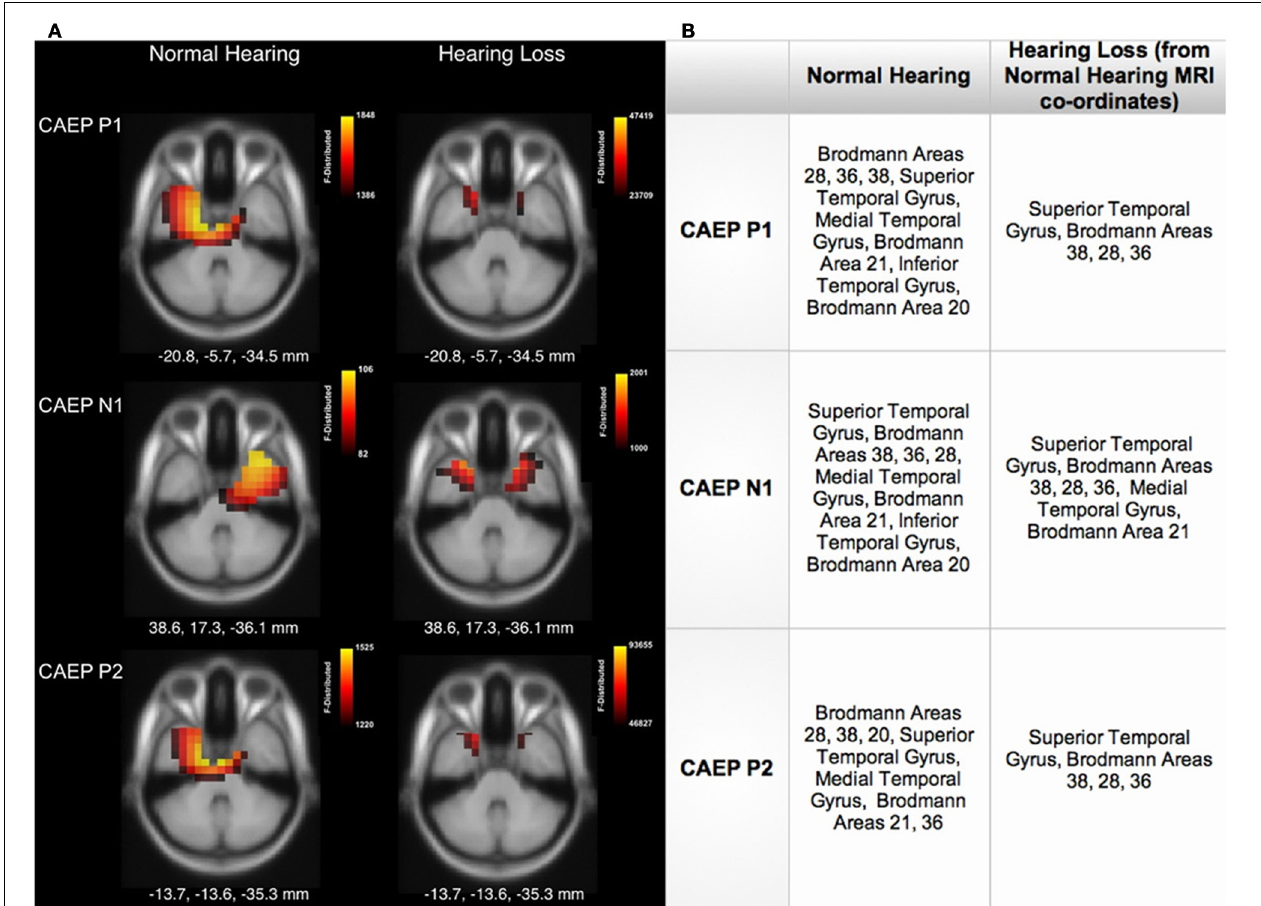
FIGURE 3 | (A) Current density reconstructions (CDR) showing cortical activation at the P1, N1, and P2 CAEP peak components on axial MRI slices for the normal hearing (NH) and hearing loss (HL) groups. The scale of the F Distribution is shown in the upper right corner ranging from red to yellow